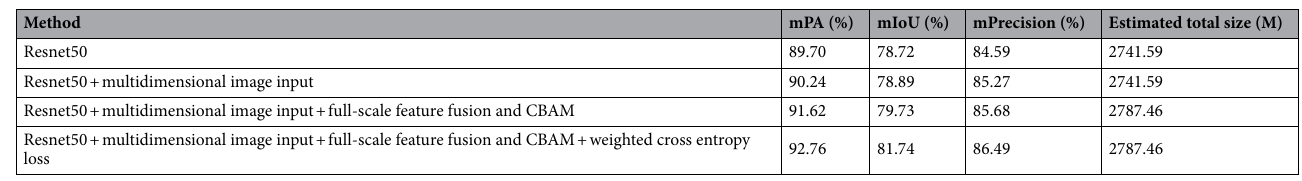
Table 2. Comparison of ablation